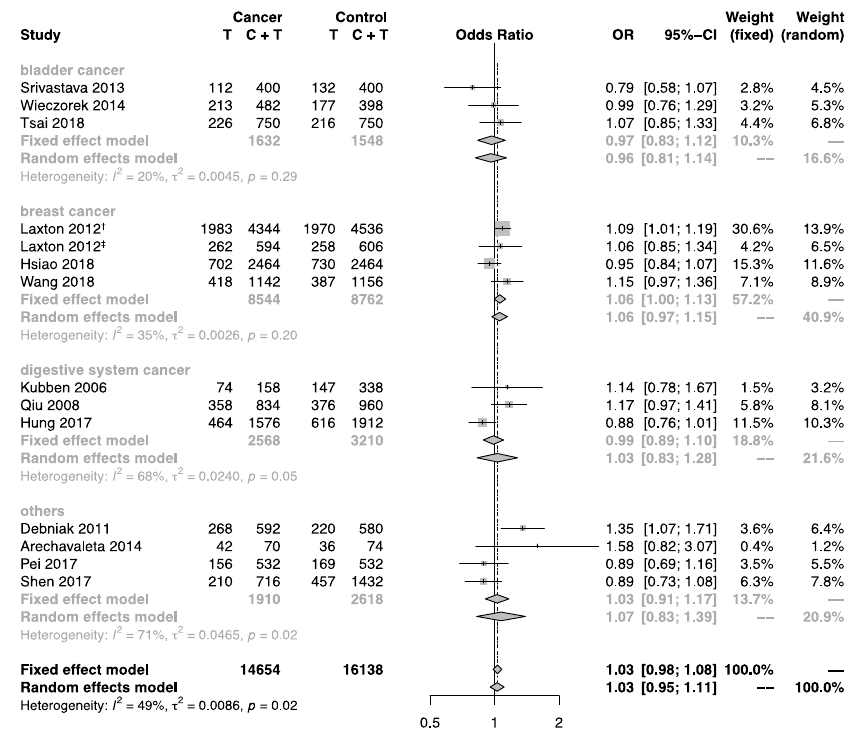
Figure 2. Forest plot showing the association between the MMP-8 rs11225395 polymorphism and cancer risk in subgroup analysis by cancer type. The pooled estimates were calculated under the allele model. The size of each gray square is proportional to the weight calculated under the fixed effect model, a black dot in a box indicates the odds ratio (OR), and black lines on either end mark the corresponding 95% confidence interval (CI). The gray diamonds represent the overall summary estimate, with 95% CI represented by their widths. The dotted vertical line and the dashed one indicate the pooled ORs calculated by the random effects model and fixed effect model, respectively. The black unbroken vertical line marks the null hypothesis (OR = 1). † marks the population of the United Kingdom in Laxton’s study (2012), and ‡ marks the population of Poland in Laxton’s study (2012).